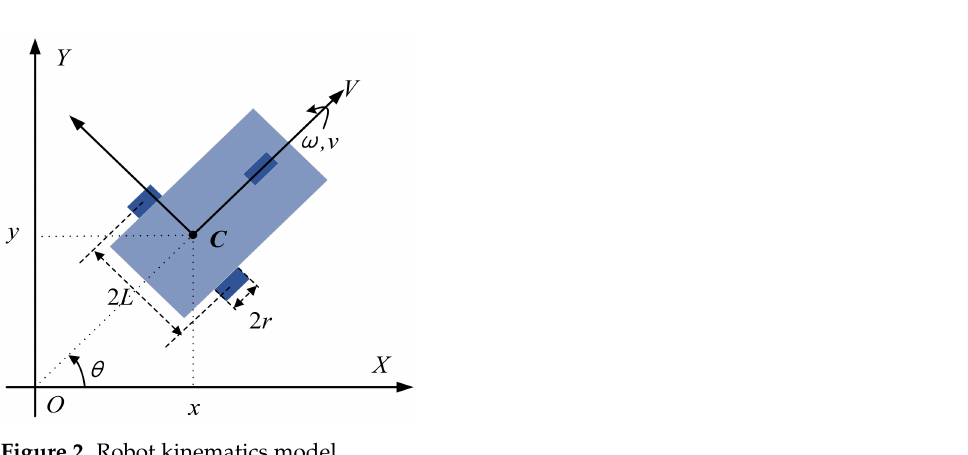
Figure 2. Robot kinematics model. Algorithm 1: The multi-robot formation control Algorithm